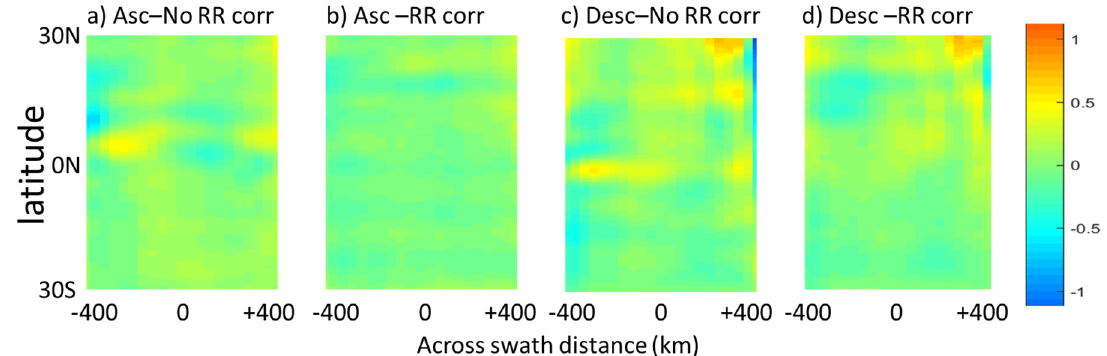
Figure 9. Mean differences (2013–2019) of SMOS minus Argo OI SSS as a function of distance to the centre of the SMOS swath and of latitude, for ascending orbits (6AM LT) without ∆ S-RR correction ( a ) and with ∆ S-RR correction ( b ) and for descending orbits (6PM LT) without ∆ S-RR correction ( c ) and with ∆ S-RR correction ( d ).